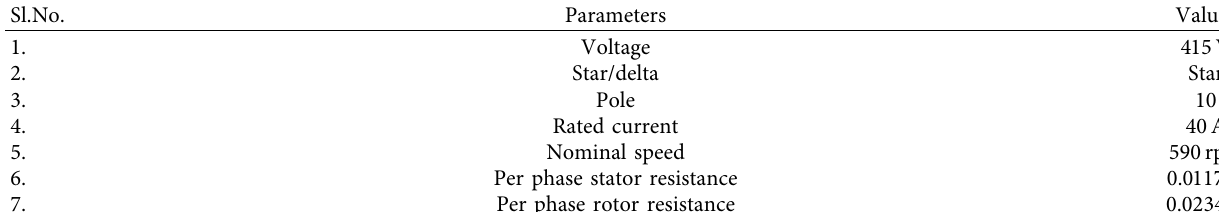
Figure 4: Sliding mode principle with the boundary layer. Table 1: Ratings of the induction motor.